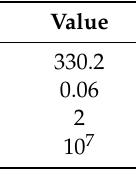
Table 2. Input parameters for the proposed numerical simulation.